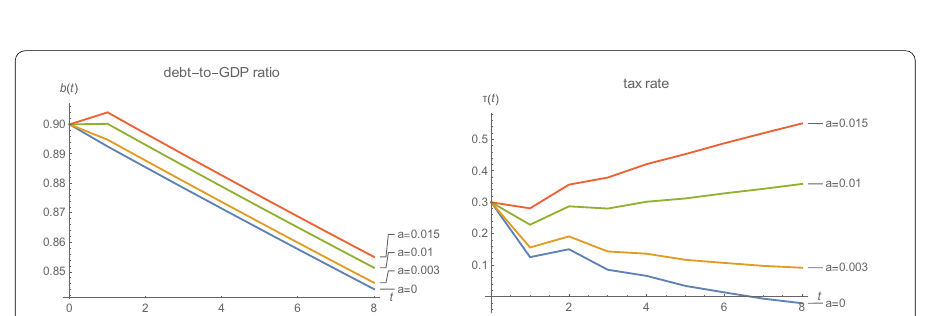
Fig. 7 Different second relation a and lower target d 1